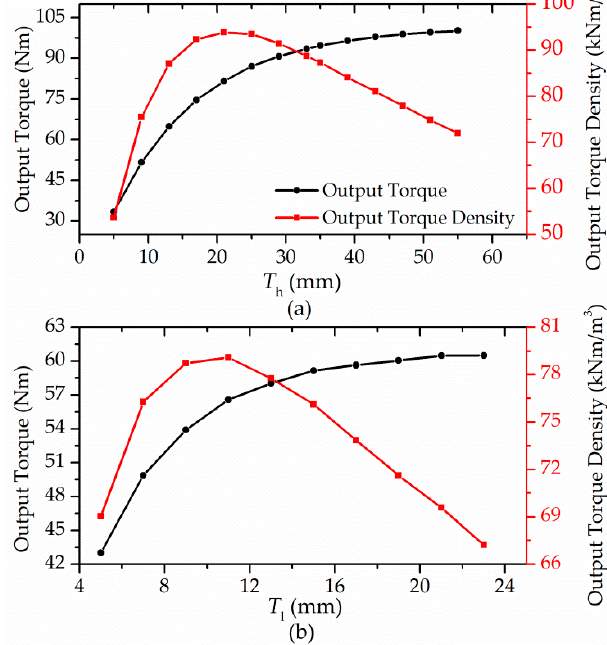
Figure 5. Output torque and output torque density curves versus T h and T l . ( a ) Axial thickness of PMs on the high-speed rotor; ( b ) Axial thickness of PMs on the low-speed rotor.